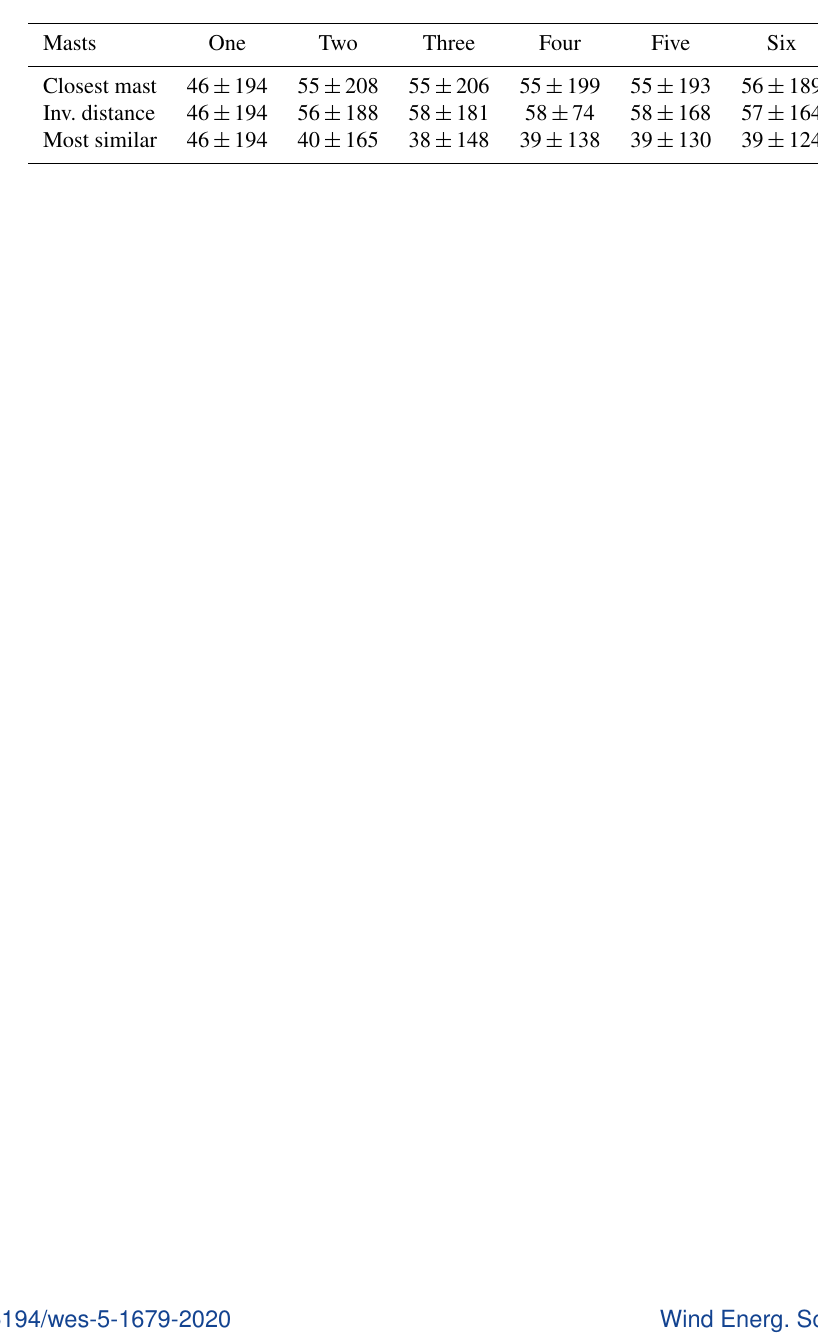
Table A1. Wind speed error (mean and standard deviation) depending on the number of predictor masts and selected strategies. Masts One Two Three Four Five Six Closest mast 0 . 09 ± 0 . 83 0 . 09 ± 0 . 87 0 . 09 ± 0 . 86 0 . 09 ± 0 . 83 0 . 10 ± 0 . 80 0 . 10 ± 0 . 78 Inv. distance 0 . 09 ± 0 . 83 0 . 10 ± 0 . 80 0 . 10 ± 0 . 77 0 . 11 ± 0 . 73 0 . 11 ± 0 . 71 0 . 11 ± 0 . 69 Most similar 0 . 09 ± 0 . 83 0 . 06 ± 0 . 72